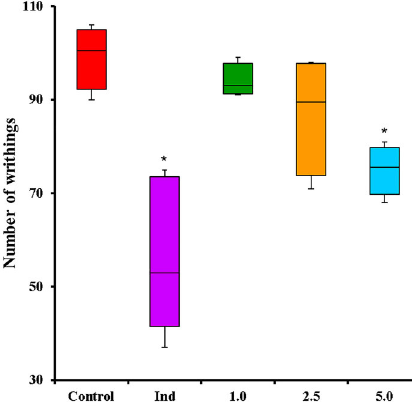
Figure 6. Effect of COPHCT in abdominal writhing test induced by the ip injection of 0.6% acetic acid in mice. Central line: median; box: 1st and 3rd quartiles; whiskers: min and max values (5 animals per group). *P o 0.05 compared to the Control group, determined by Kruskal Wallis and Mann-Whitney U tests. Groups: Control (PBS 10.0 mL/kg, ig ); Ind (25.0 mg/kg indomethacin, ig ); 1.0, 2.5, and 5.0 (COPHCT 1.0, 2.5, and 5.0 mg/kg, ig